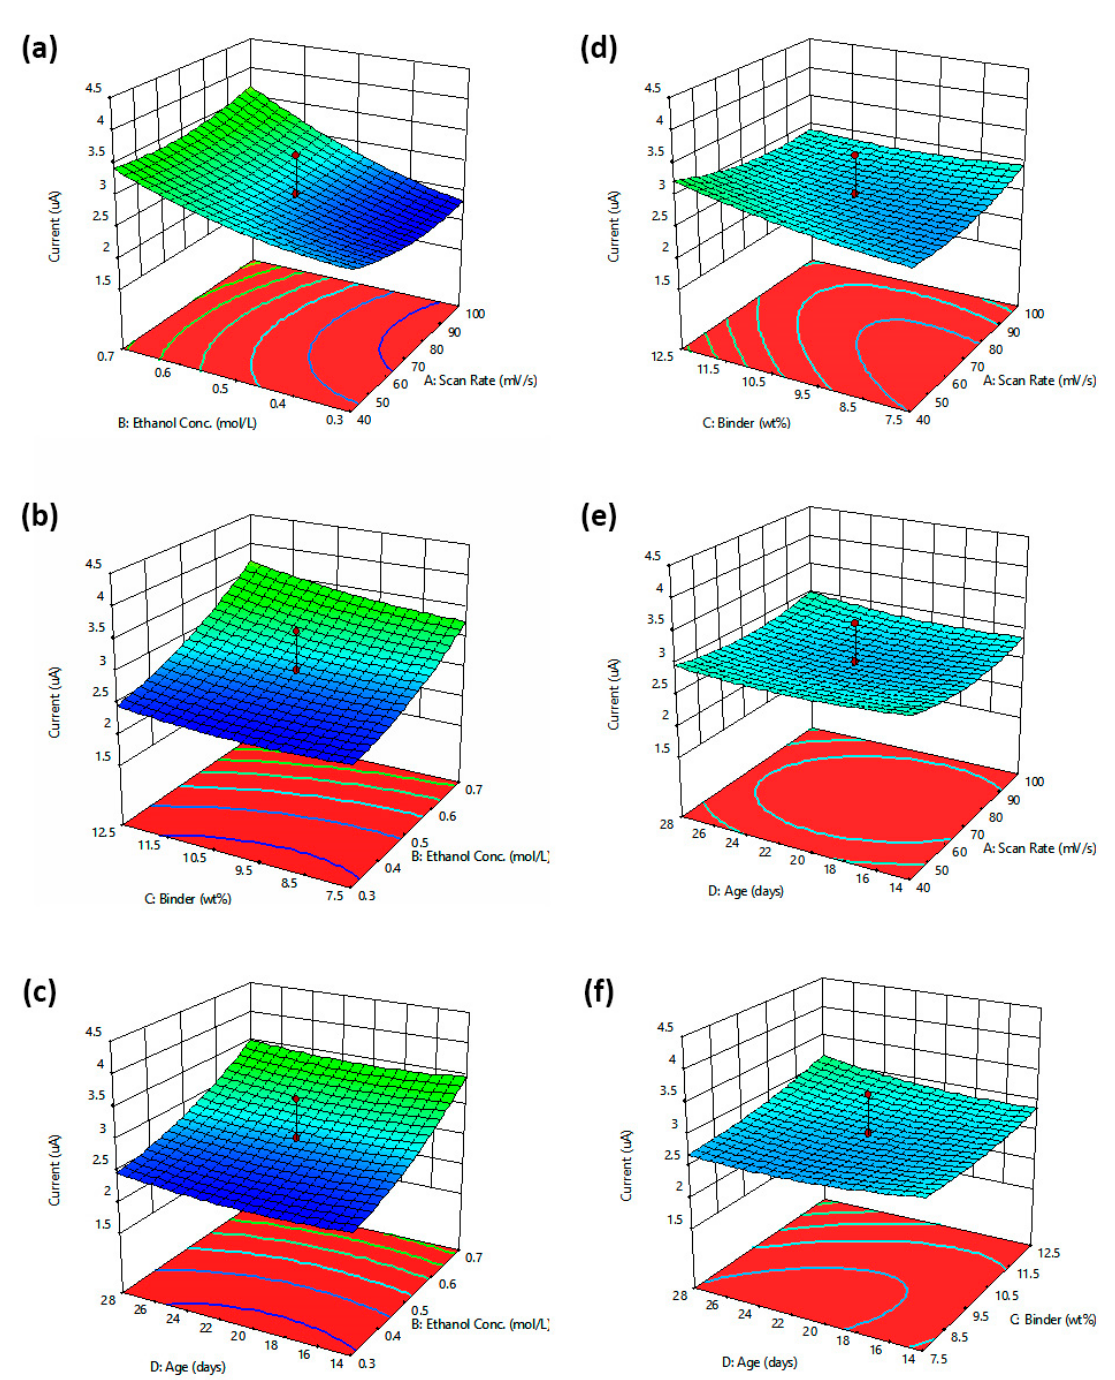
Figure 7. The 3D response surface plots for electrical current versus various variables. Graphs studies the simultaneous effects of ( a ) scanrate (mV/s) and ethanol concentration (mol/L), ( b ) binder (wt%) and ethanol concentration (mol/L), ( c ) age (days) and ethanol concentration (mol/L), ( d ) binder (wt%) and scanrate (mV/s), ( e ) age (days) and scanrate (mV/s), ( f ) age (days) and binder (wt%), on the current ( μ A) at the oxidation peak potential.